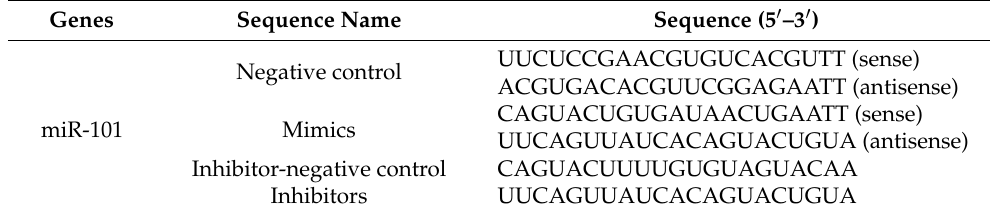
Table 2. RNA oligonucleotide sequence